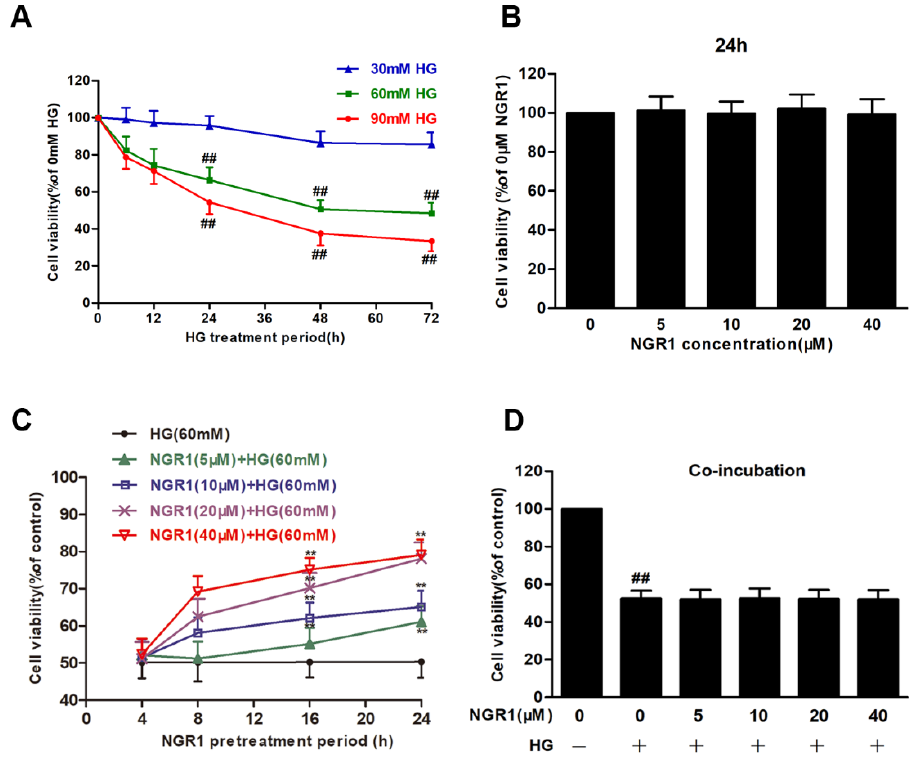
Figure 1. NGR1 preconditioning exerted a protective effect on HG ‐ induced cell death in rMC ‐ 1 cells. Cell viability was tested by an MTT reduction assay. ( A ) HG increased cell death in rMC cells in concentration ‐ and time ‐ dependent manners. ( B ) NGR1 showed no effect on the cell viability of rMC cells. ( C ) NGR1 preincubation reversed HG ‐ induced cell death in rMC cells in a dose ‐ and time